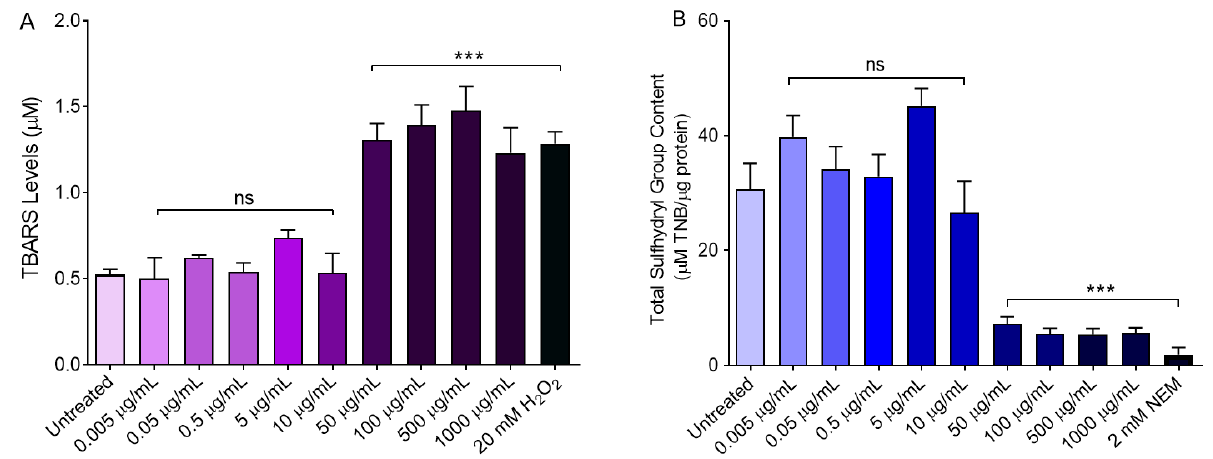
Figure 2. Oxidative stress assessment. Human erythrocytes have been exposed to increasing concentrations of freeze-dried Açaì extract for 1 h at 37 °C. ( A ) Estimation of TBARS levels—a marker of lipid peroxidation—as well as ( B ) total sulfhydryl group content (µM TNB/µg protein). ns, not statistically significant versus control; ***, p < 0.001 versus control, ANOVA with Dunnet’s post-test ( n = 10).